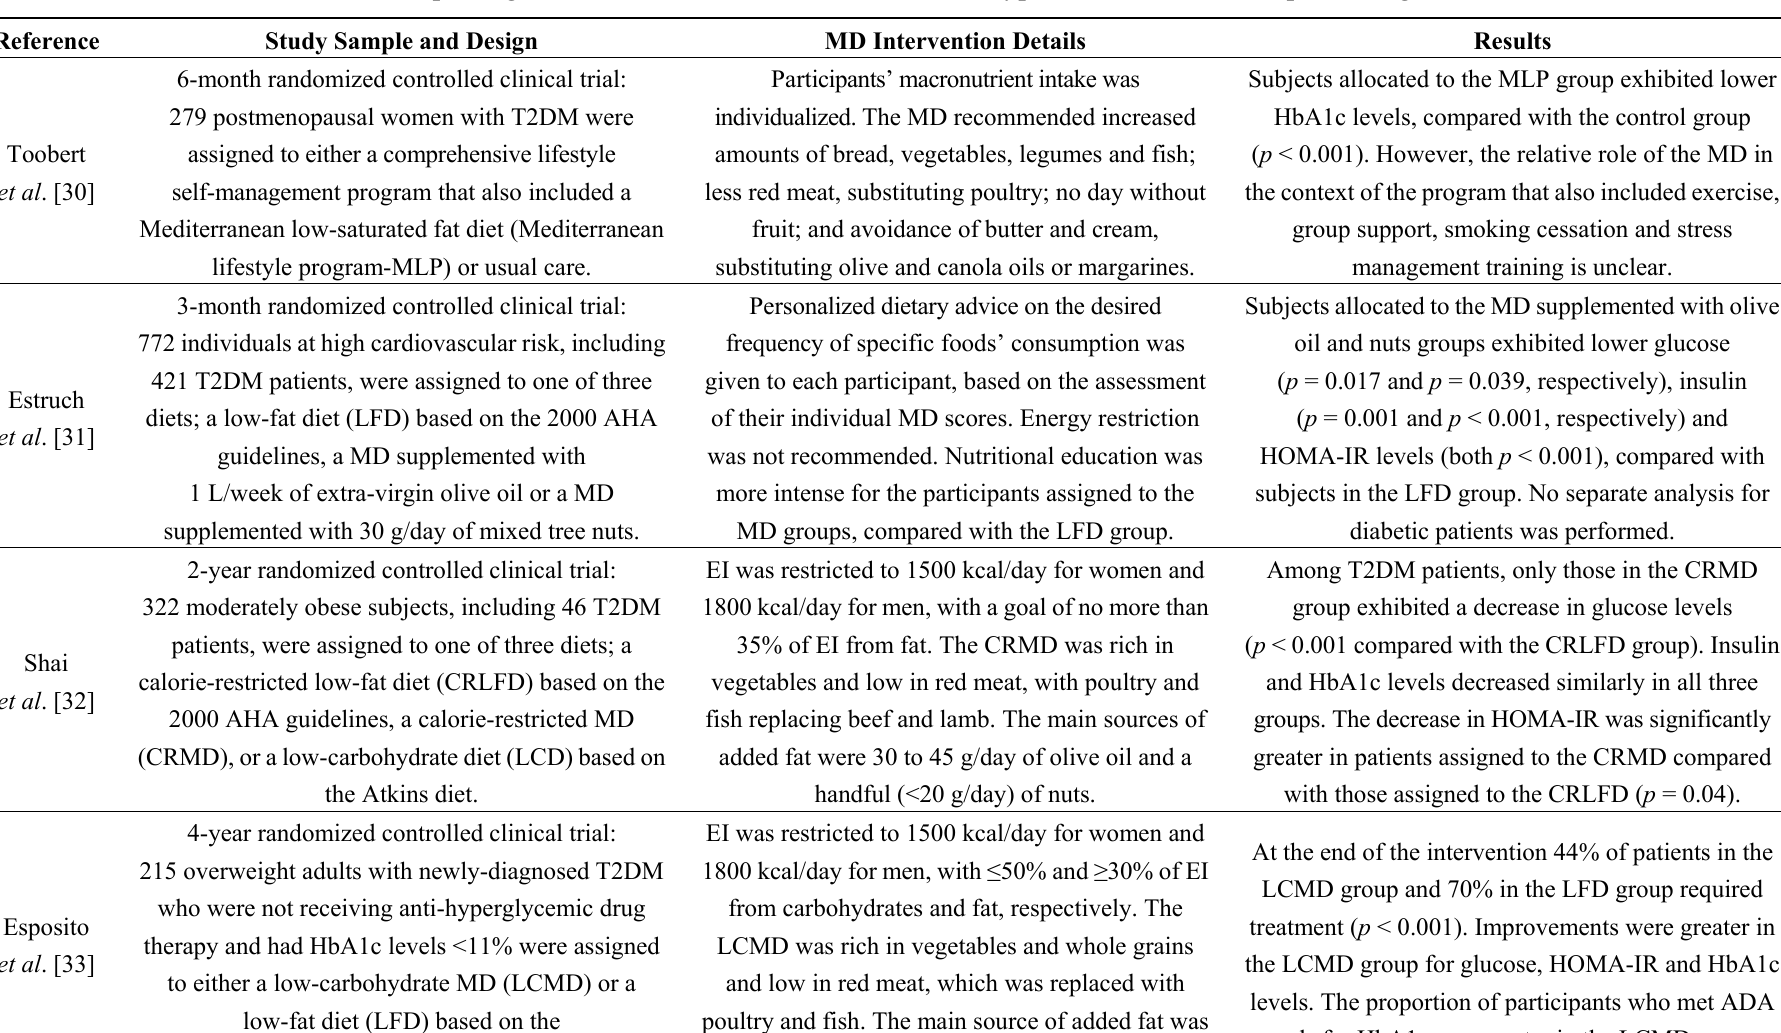
Table 2. Interventional studies exploring the effect of the Mediterranean diet on type 2 diabetes mellitus patients’ glucose homeostasis indices.